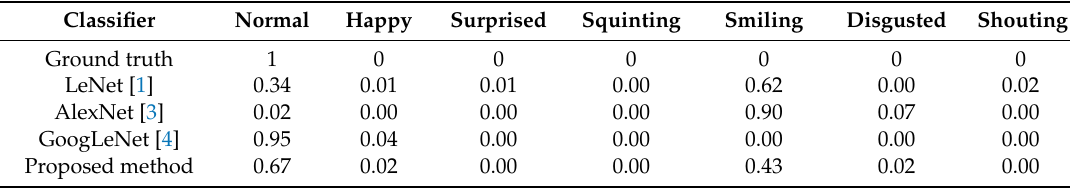
Table 14. Example photo (1)-360 recognition